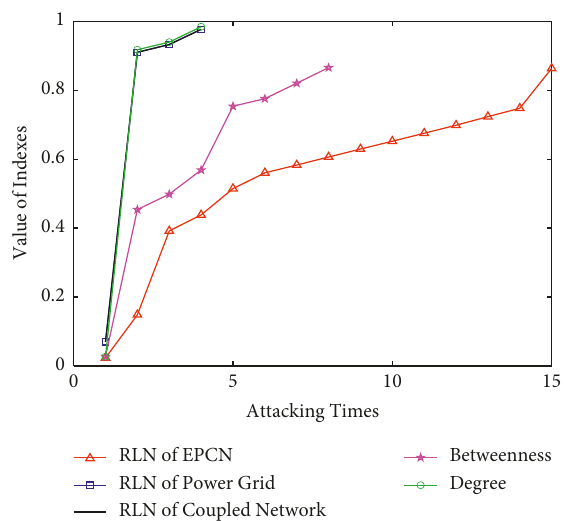
Figure 14: Indexes curve of 5 modes under physical attacks. Table 3: Attacking times and beginning RLN of 5 modes.